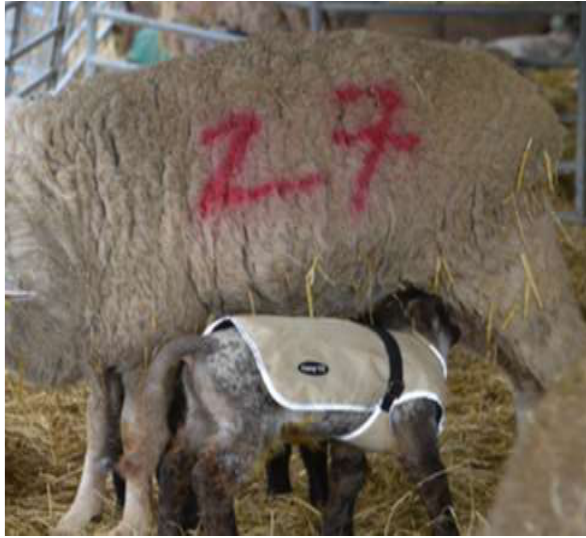
Figure 1. Lamb feeding while wearing the jacket (newborn).